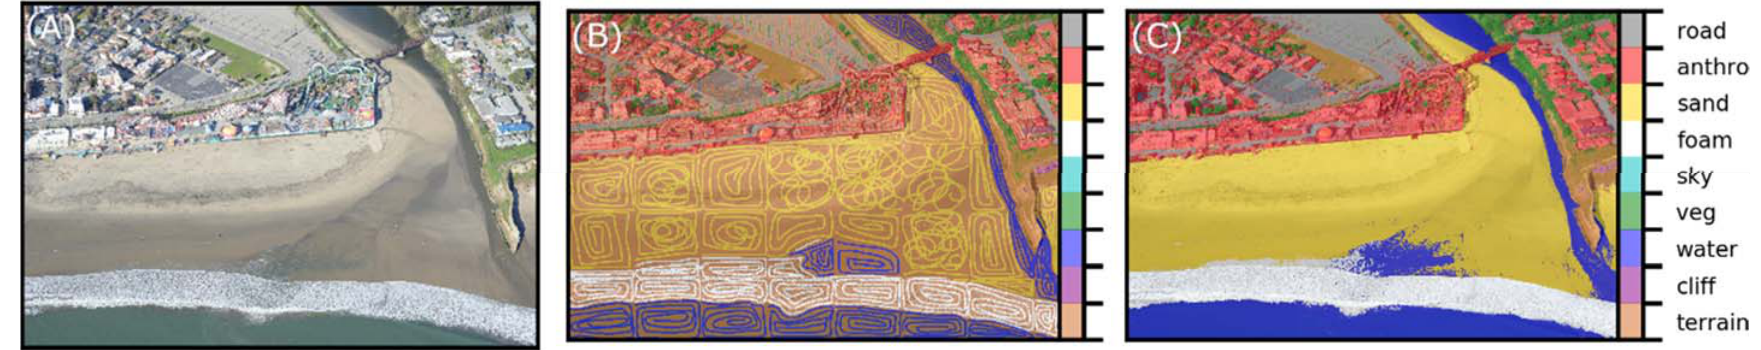
Figure 1. Application of the semi-supervised CRF at Seabright Beach, Santa Cruz, California for generation of DCNN training tiles and ground-truth labeled images. From left to right: ( A ) the input image; ( B ) the hand-annotated sparse labels; and ( C ) the resulting CRF-predicted pixelwise labeled image.